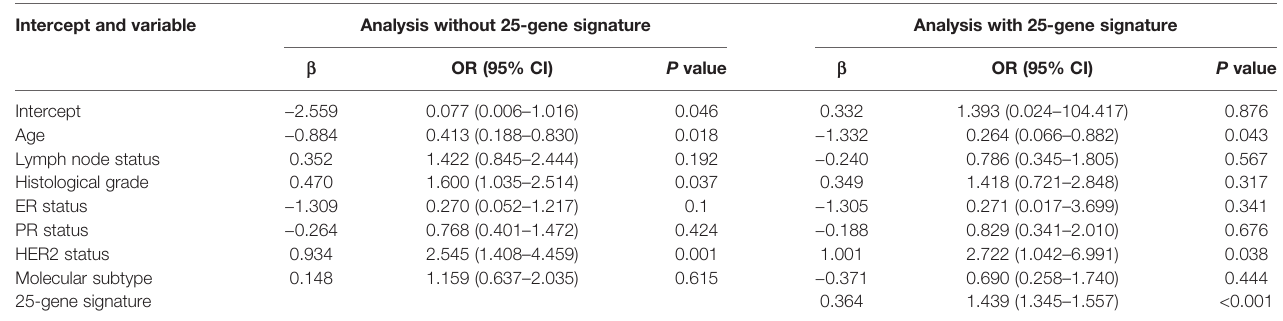
TABLE 2 | Multivariate logistic regression analyses for predicting pCR to neoadjuvant chemotherapy. Intercept and variable